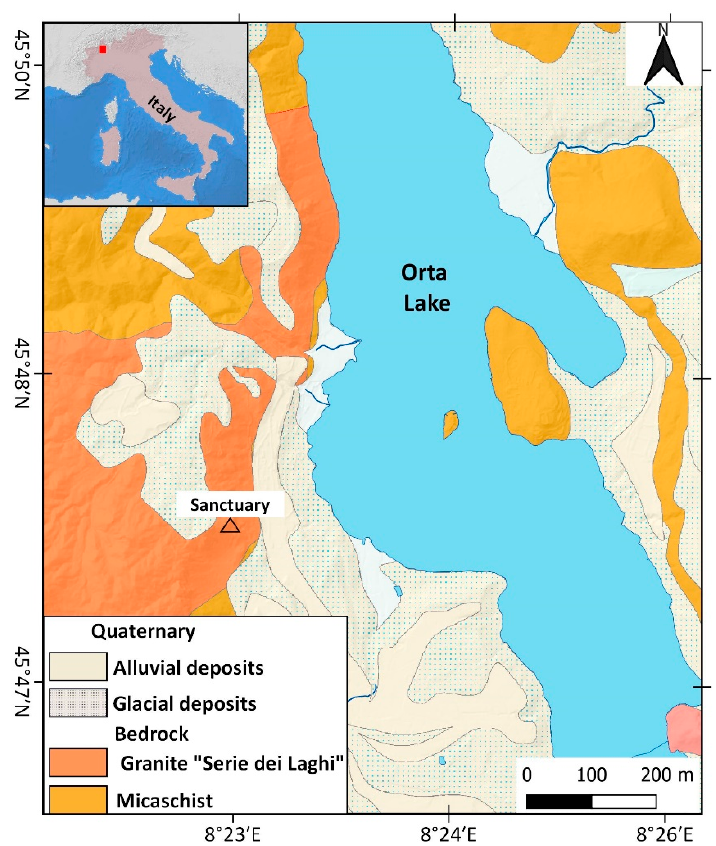
Figure 1. Location and geological settings of Madonna del Sasso site from the geological map of Piemonte retrieved from the WebGIS service of ARPA Piemonte and Istituto di Geoscienze e Georisorse - Consiglio Nazionale delle Ricerche CNR-IGG (Geosciences and Earth Resources Institute of National Research Council of Italy) [25], based on the work of[26].